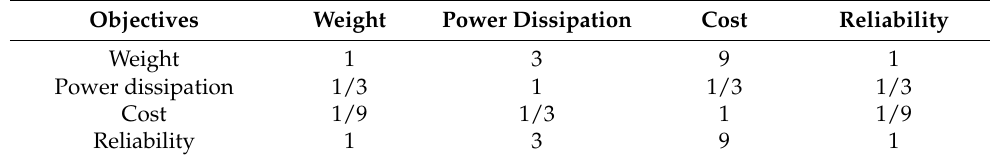
Table 3. The association between the objectives.